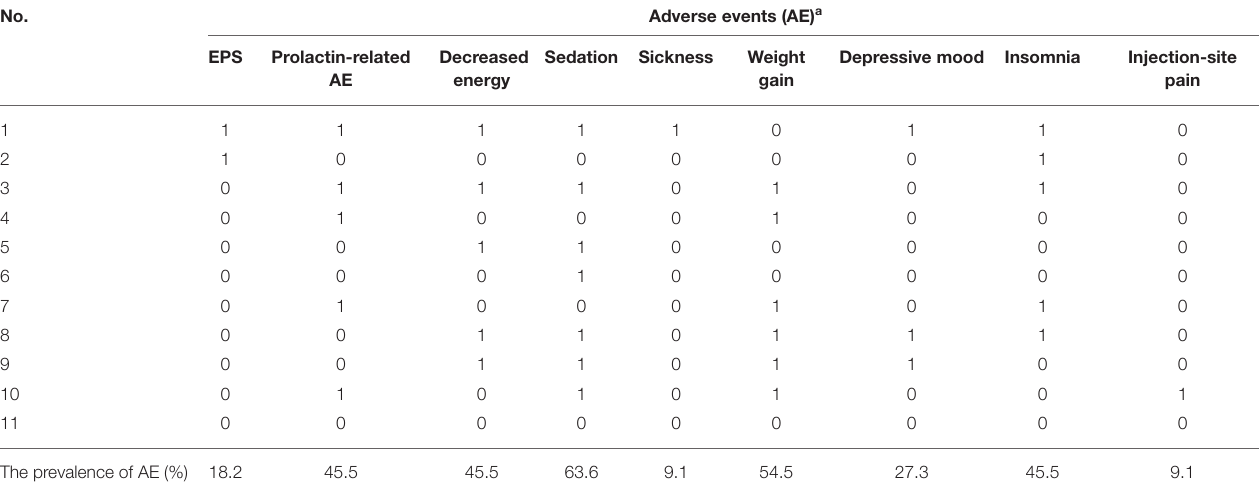
TABLE 4 | The prevalence of adverse events during the treatment. No. Adverse events (AE) a EPS Prolactin-related Decreased Sedation Sickness Weight Depressive mood Insomnia Injection-site AE energy gain